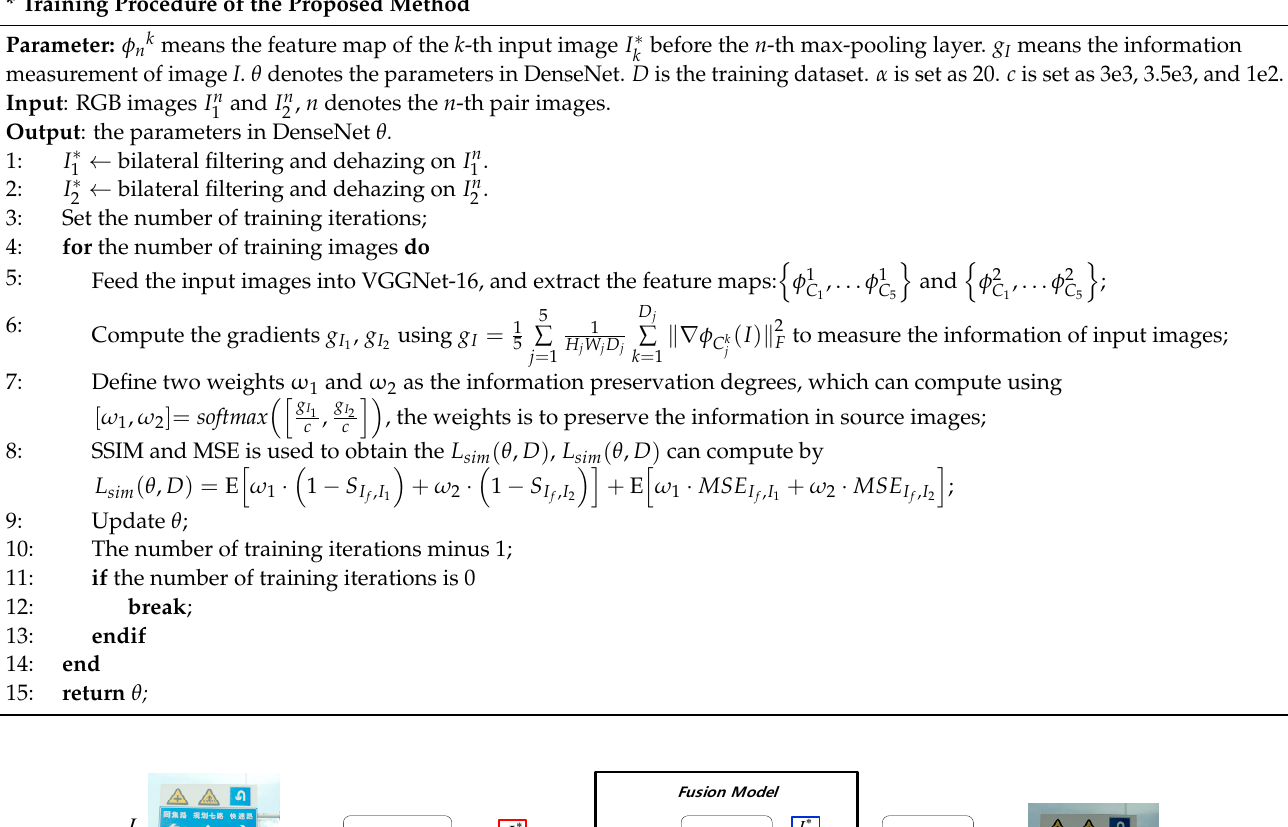
Algorithm 1: The description of the training procedure * Training Procedure of the Proposed Method